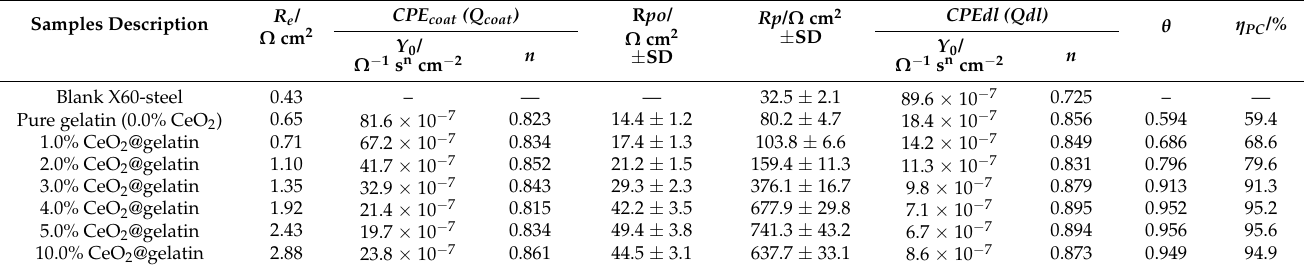
Table 2. EIS fitting parameters for blank and coated X60-steel in 15% HCl solution at 50 ◦ C. Samples